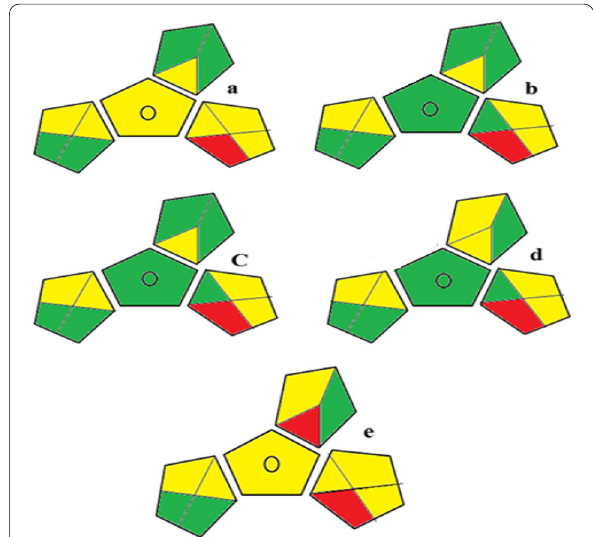
Fig. 2 GAPI assessment of the green profile of the evaluated procedures for determination of TIG in intravenous infusion solution by the proposed CZE method ( a ), spectrophotometric methods, method I ( b ), method II ( c ), method III ( d ) and reference RP‑HPLC method ( e